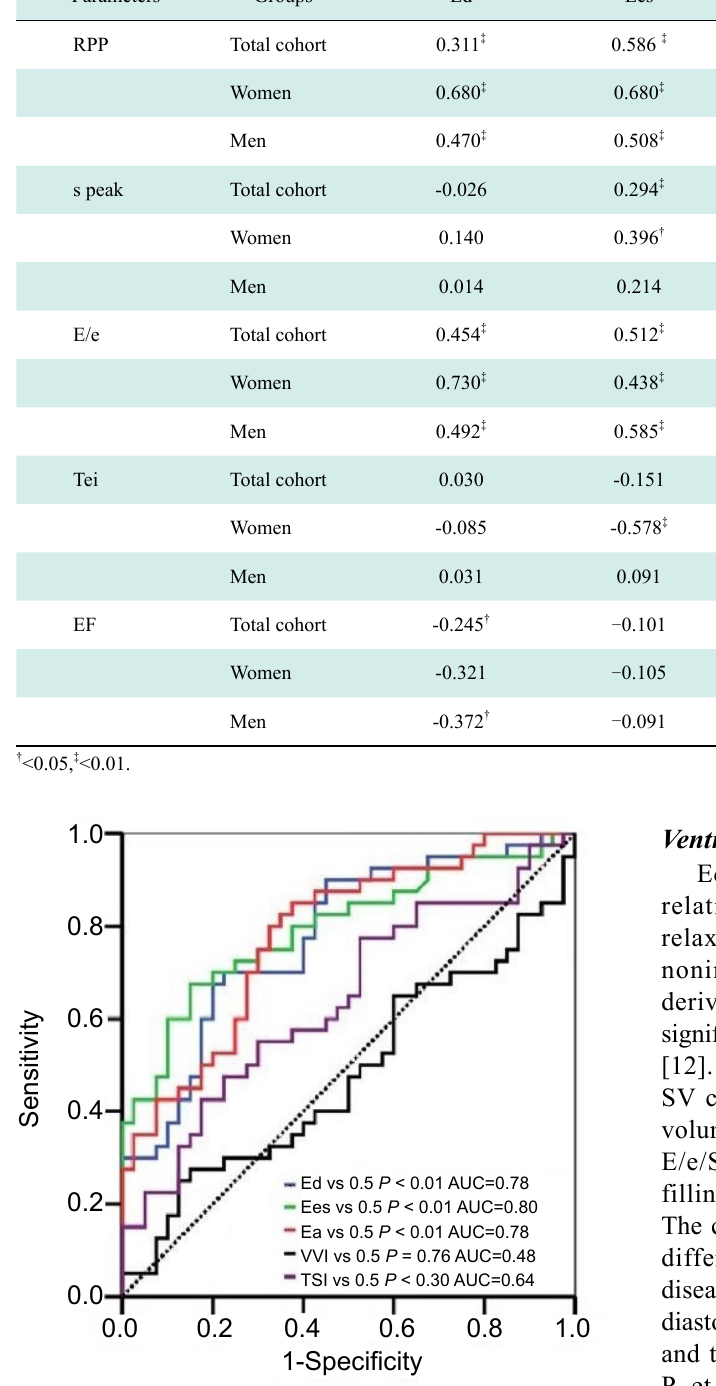
Table 4 The correlation of cardiovascular stiffness with heart function Parameters